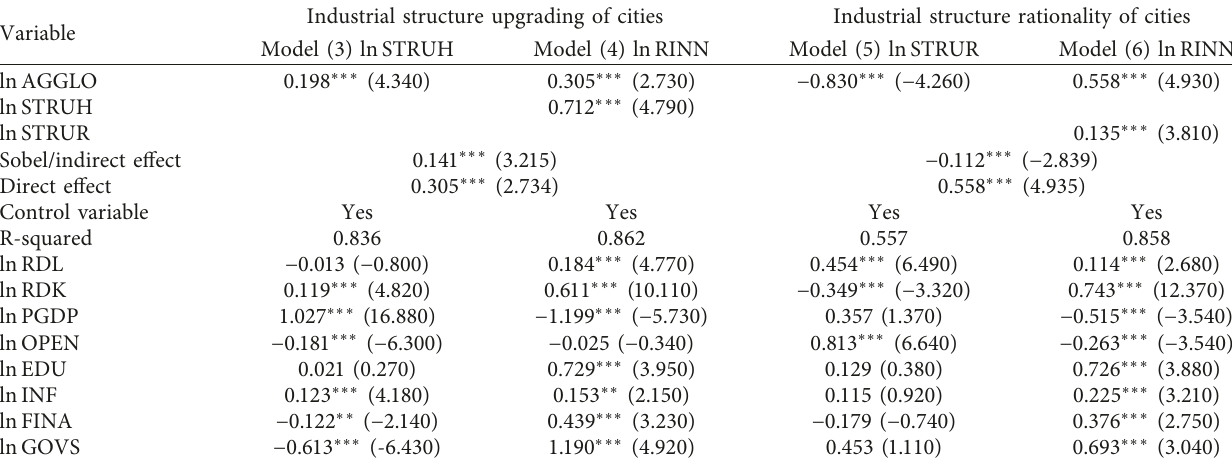
Table 4: Mediating effect test